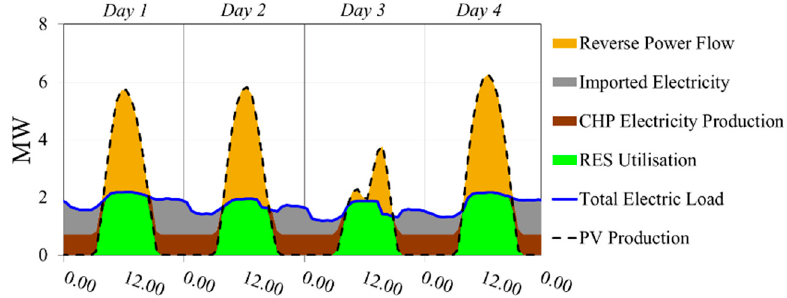
Figure 7. Electricity production share for the case with no P2G.